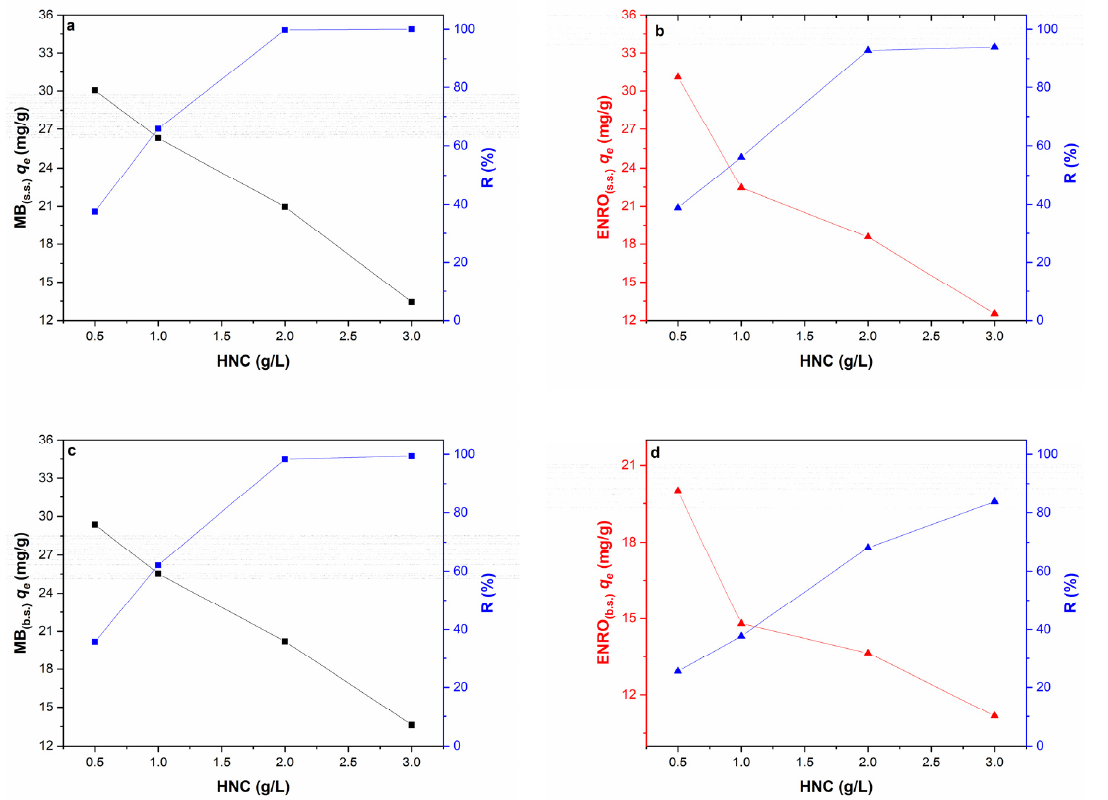
Figure 4. Effect of HNC dosage on removal efficiency and adsorption capacity for ( a ) MB (s.s.) (Co = 40 mg/L, pH = 6.2, contact time 1 h) ( b ) ENRO (s.s.) (C 0 = 40 mg/L, pH = 6.2, contact time 1 h, T = 28 °C) ( c ) MB (b.s.) (binary system, C 0 MB = 40 mg/L, C 0 ENRO = 40 mg/L, pH = 6.2, contact time 1 h, T = 28 °C) and ( d ) ENRO (b.s.) (binary system, C 0 MB = 40 mg/L, C 0 ENRO = 40 mg/L, pH = 6.2, contact time 1 h, T = 28 °C).